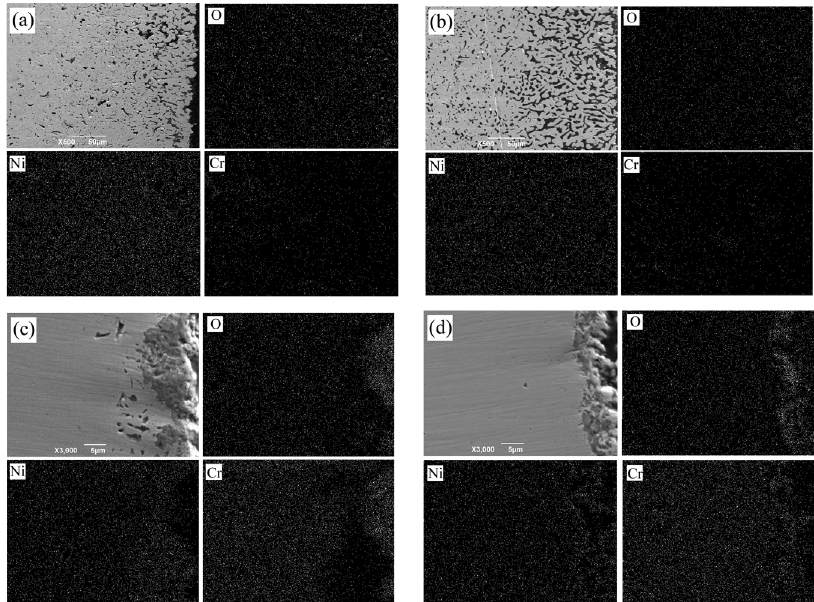
Figure 8: Cross-section views and elemental distribution maps of the corrosion products formed in (a) NaCl þ MgCl 2 (2:3), (b) KCl þ MgCl 2 (2:3), (c) NaCl þ CaCl 2 (2:3) and (d) KCl þ CaCl 2 (2:3) mixtures of molten salts after 20 h at